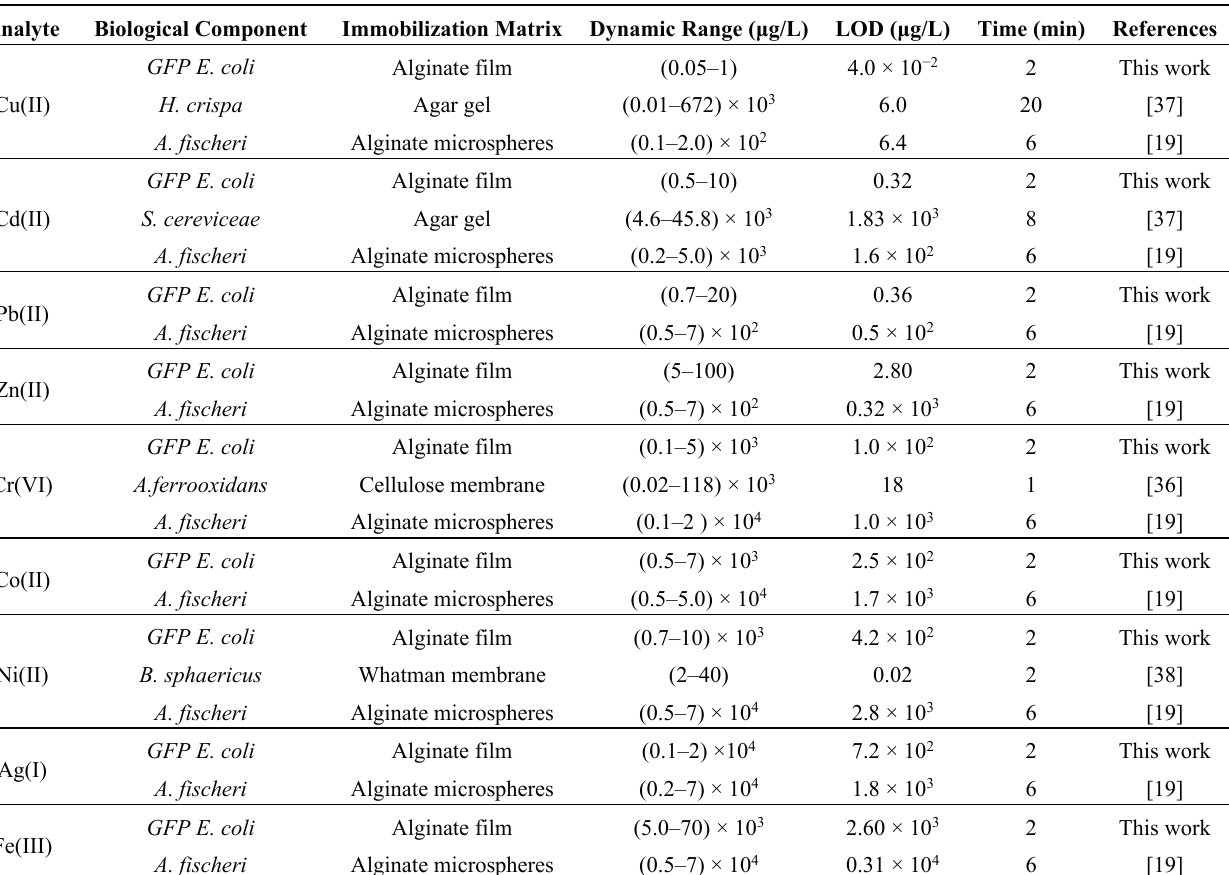
Table 2. Comparison between the developed microbial biosensor performance and other microorganism-based biosensors for the detection of Cu(II), Cd(II), Pb(II), Zn(II), Cr(VI), Co(II), Ni(II), Ag(I) and Fe(III) toxicities.